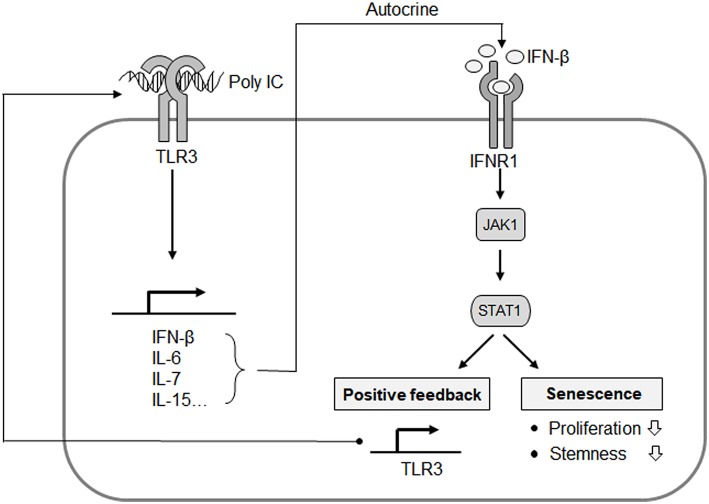
Proposed mechanistic model for the TLR3-mediated senescence of MSCs. IFN-β is a predominant component of TLR3-dependent SASP, and exerts its autocrine action to upregulate TLR3 and suppress cell proliferation. JAK1 is a signaling mediator linking IFN-β to TLR3 expression and the process of MSC senescence. This represents an autocrine regulatory loop of SASP evoked by TLR3 activation.